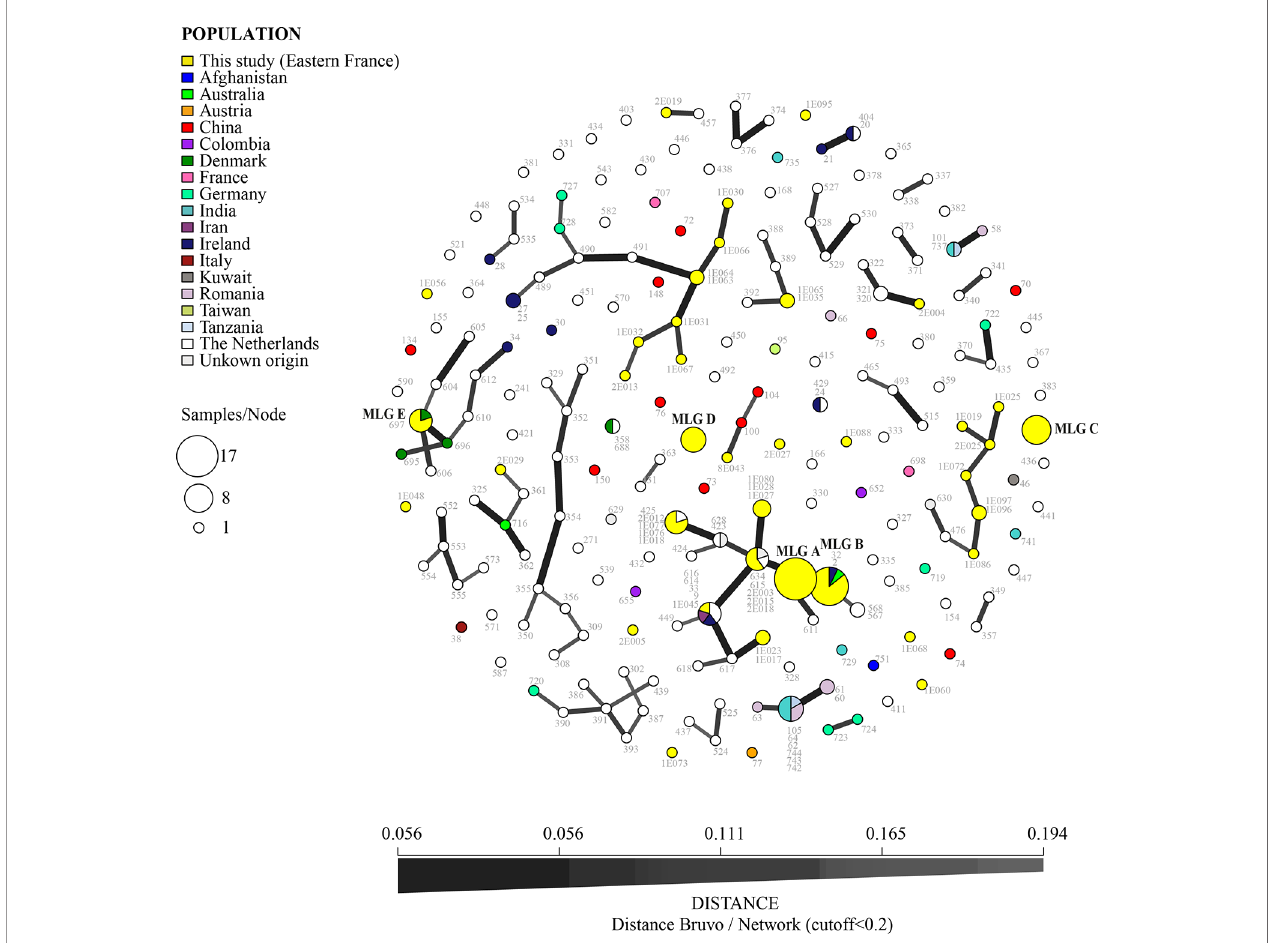
FIGURE 4 | Minimum spanning network for TR 34 /L98H isolates (nine microsatellite loci STR Af using Bruvo ’ s distance, with distance cutoff < 0.2) from Besanc ̧ on mycology team and from the world (AfumID application). Colors represent the origin of sampling and numbers are ID isolates. Link thickness is proportional to genotype similarity. The most common multilocus genotypes (MLGs) found in Besanc ̧ on laboratory are denoted by the letters A, B, C, D, and